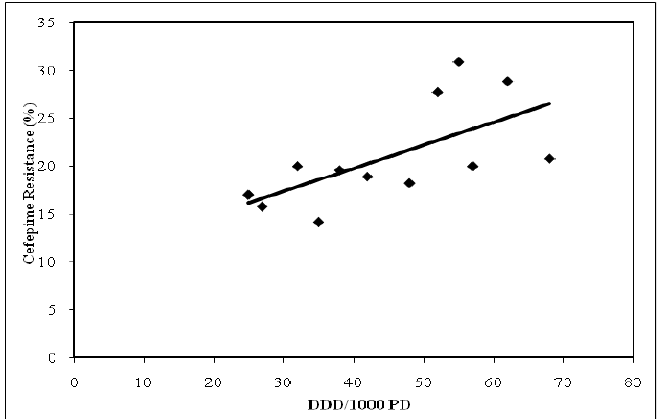
MIC = minimum inhibitory concentration: S = susceptible; I = Intermediate; R = resistant Figure 3. Relationship between cefepime utilization and resistance among P. aeruginosa isolates: July 2000–June 2006, UCDMC (R = 0.64), P = 0.013.